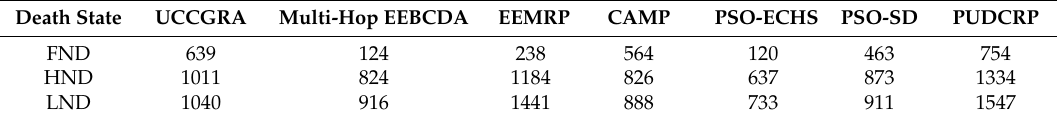
Table 2. The average rounds of PUDCRP in the 400 m × 400 m network area (n =